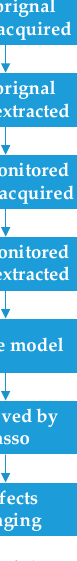
Figure 3. The flowchart of the tomography